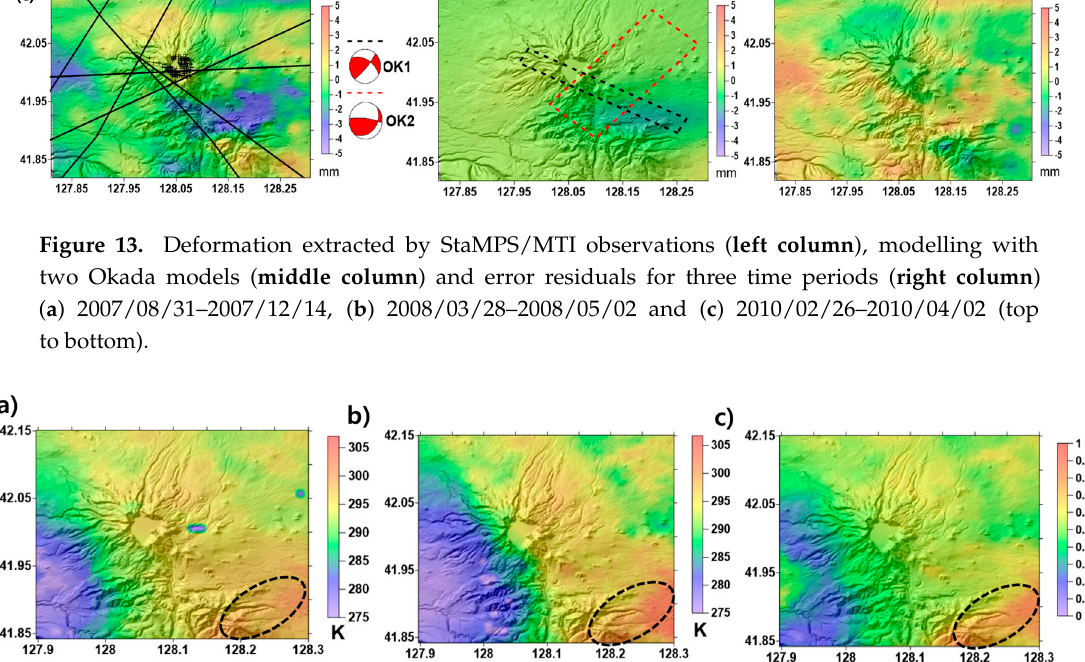
Figure 14. MODIS thermal anomaly around deformation areas ( a ) 2007/07/26, ( b ) 2009/04/24, ( c ) average of 10 normalized surface temperature of cloud free MODIS land temperature products during 2007–2010.